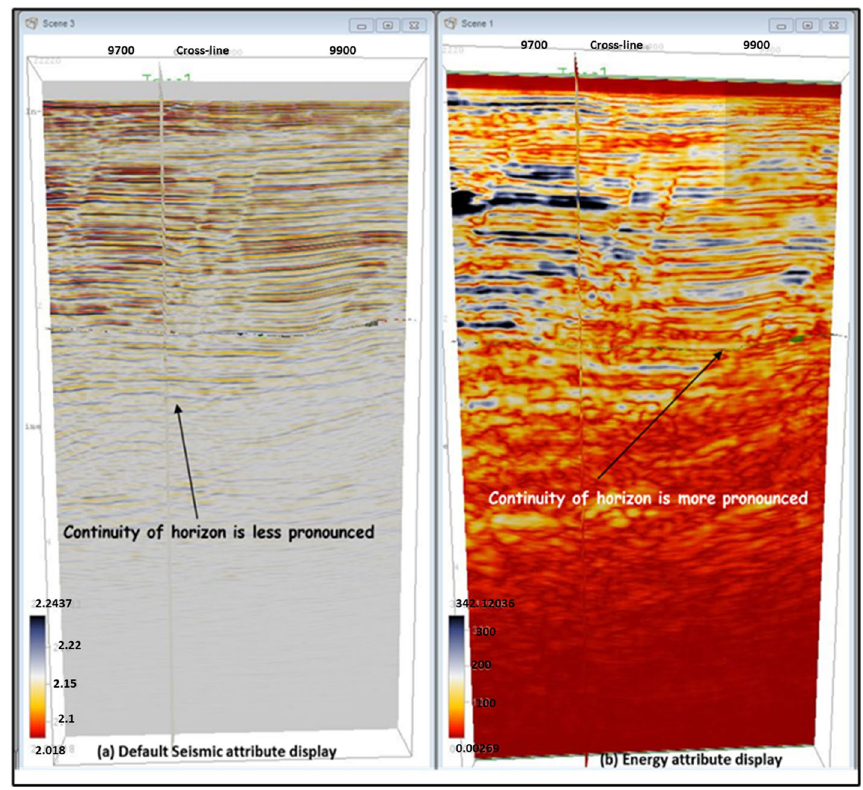
Fig. 10 Enhanced horizons using the energy attribute. a Default seismic. b Energy attribute